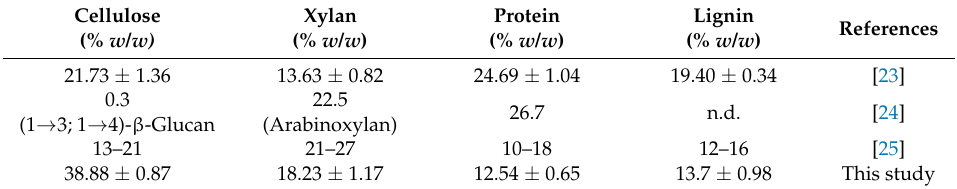
Table 1. Comparative study of compositional analyses of BSG from various